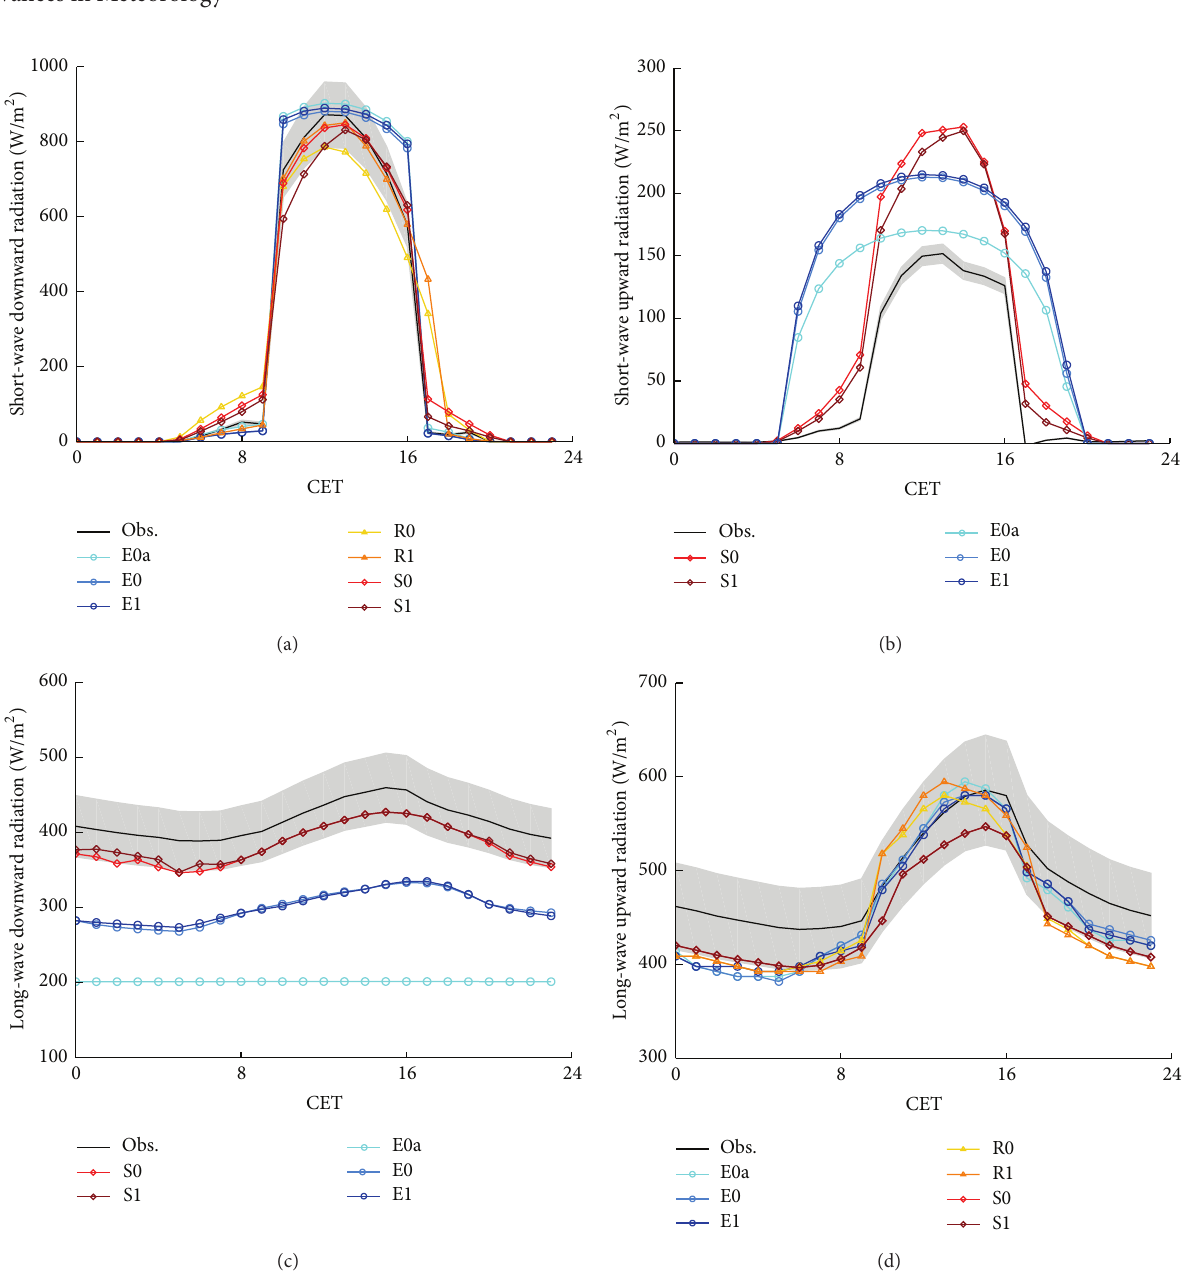
Figure 7: Comparison of simulated and observed (a) short-wave downward radiation, (b) short-wave upward radiation, (c) long-wave downward radiation, and (d) long-wave upward radiation on 7, 23, 2013, for the greened site in front of the fac¸ade simulated with ENVI-met 3 (E0a), unforced (E0) and forced ENVI-met 4 (E1), RayMan without (R0) and with global radiation from observation (R1), and SOLWEIG without (S0) and with global radiation from observation (S1). The gray areas indicate the accuracy range of the